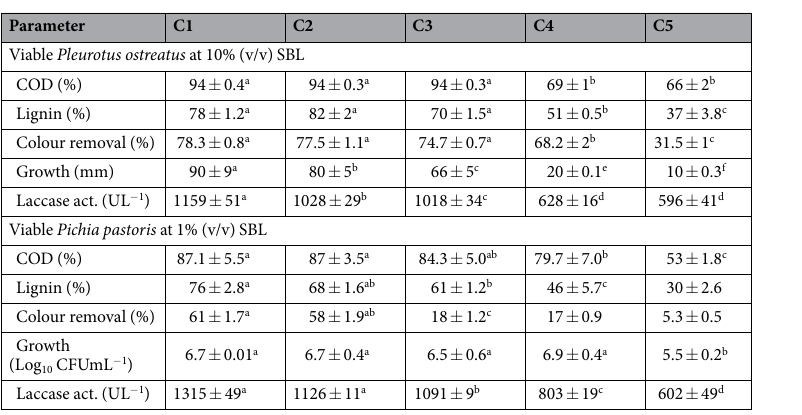
Table 3. Operating cycles: percentage of decolourisation with P. ostreatus and P. pastoris VB. Five complete treatment cycles were carried out to estimate the number of cycles for which the biomass from both fungi could be used. The decolourisation percentage, TOC and COD removal, laccase activity, and pH were assessed. P. ostreatus viability was determined by PDA radial growth, and P. pastoris viability was determined by YPG agar microdrop counts. C1 (cycle number 1), C2 (cycle number 2), C3 (cycle number 3), C4 (cycle number 4), C5 (cycle number 5), CFU (colony forming